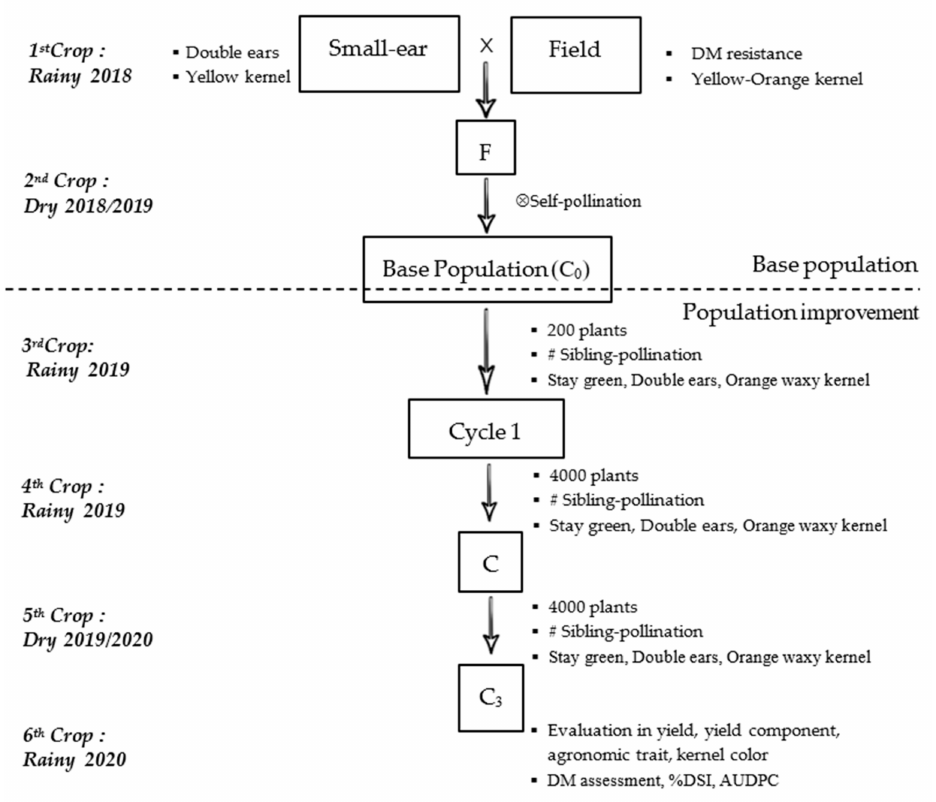
Figure 1. Schematic diagram for base population and population improvement of orange small-ear waxy corn populations with three cycles of modified mass selection for stay green, prolific ears, and orange waxy kernels from 2018 to